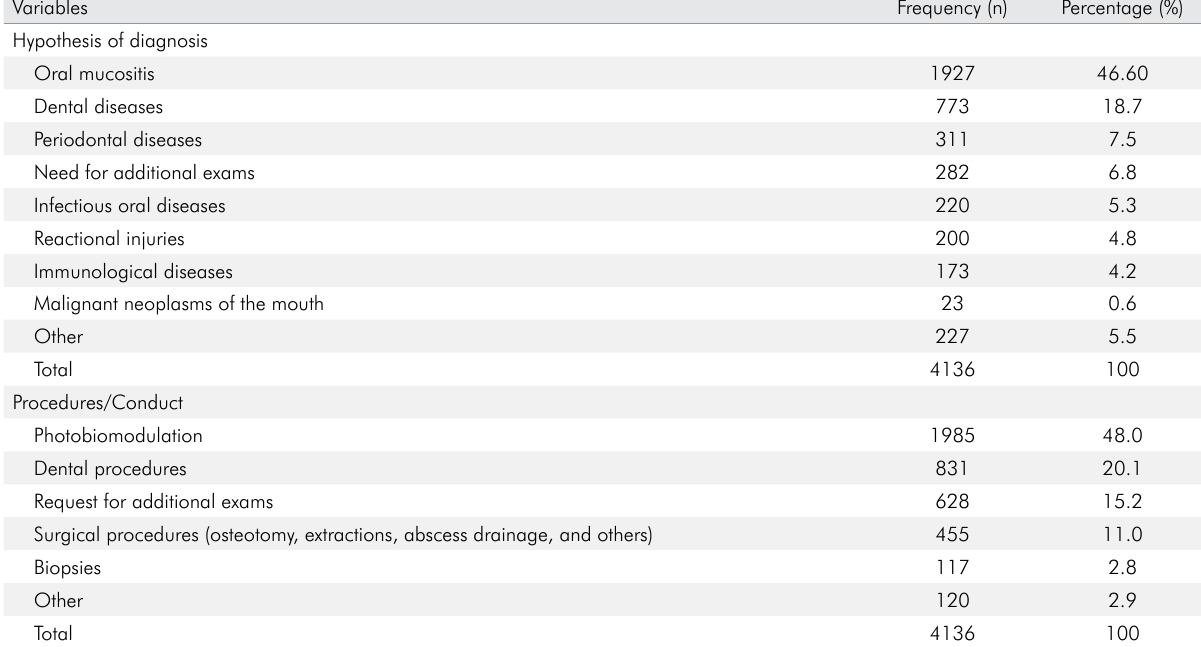
Table 3. Simple (n) and relative (%) frequencies of data related to demand